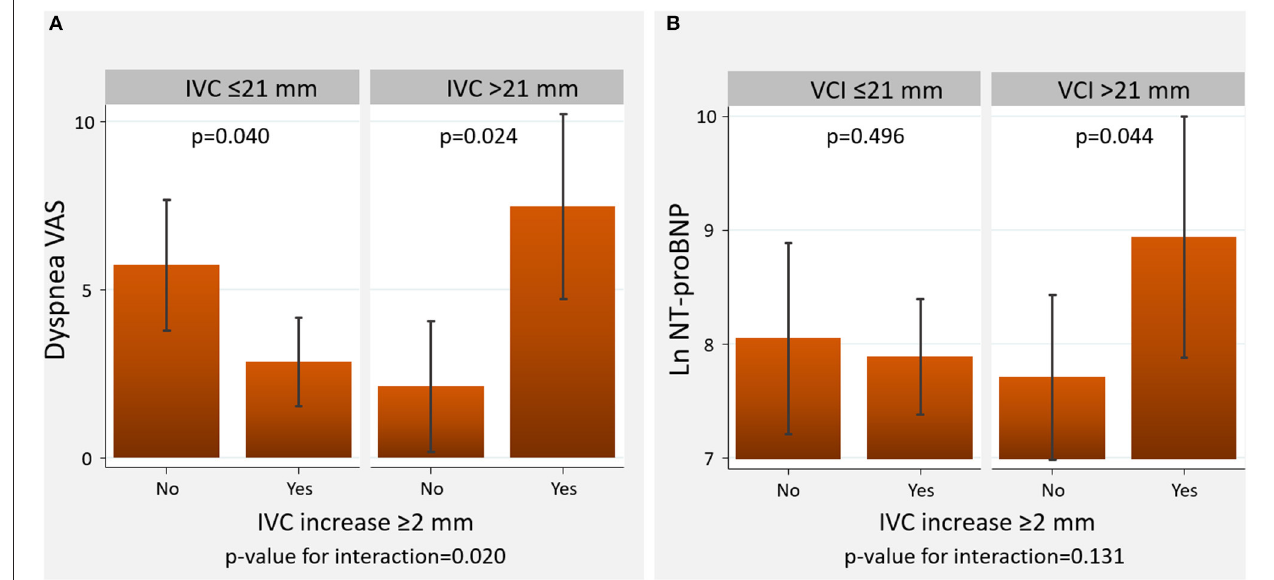
FIGURE 4 | Changes in VAS and the logarithm of NT-proBNP across baseline IVC diameter and the presence of IVC increase at 3-h. (A) Visual analog scale. (B) Amino-terminal pro-brain natriuretic peptide. NT-proBNP, amino-terminal pro-brain natriuretic peptide, IVC, inferior vena cava; VAS, visual analog